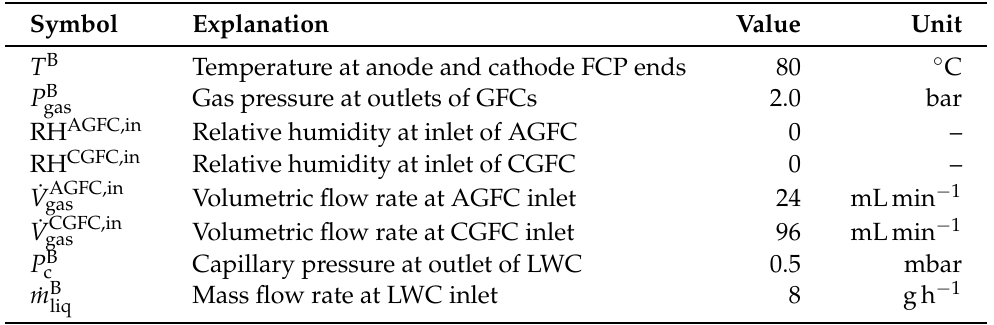
Table 2. Base case operating